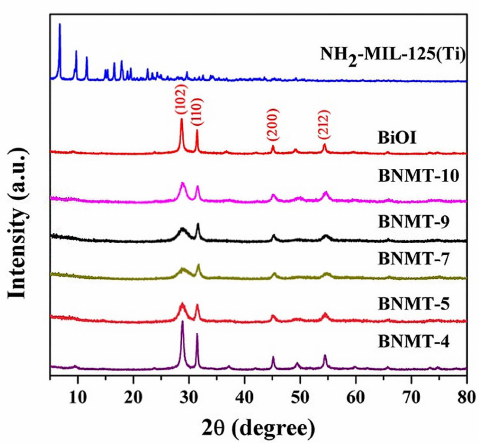
Figure 1. XRD patterns of BiOI, NH 2 -MIL-125(Ti), and BiOI/NH 2 -MIL-125(Ti) with different com- posite ratios.